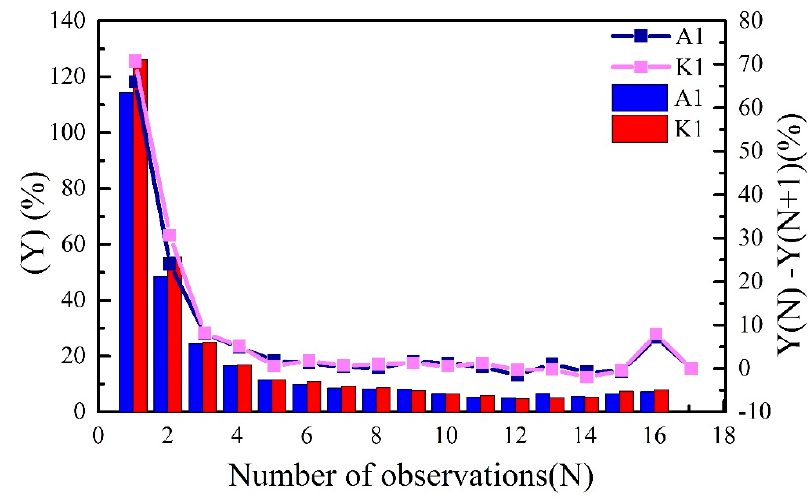
Figure 5. Relative errors (Y, bars) corresponding to the number of observations (N), and the first order error differences (Y(N) – Y(N + 1), lines) between N and N + 1.